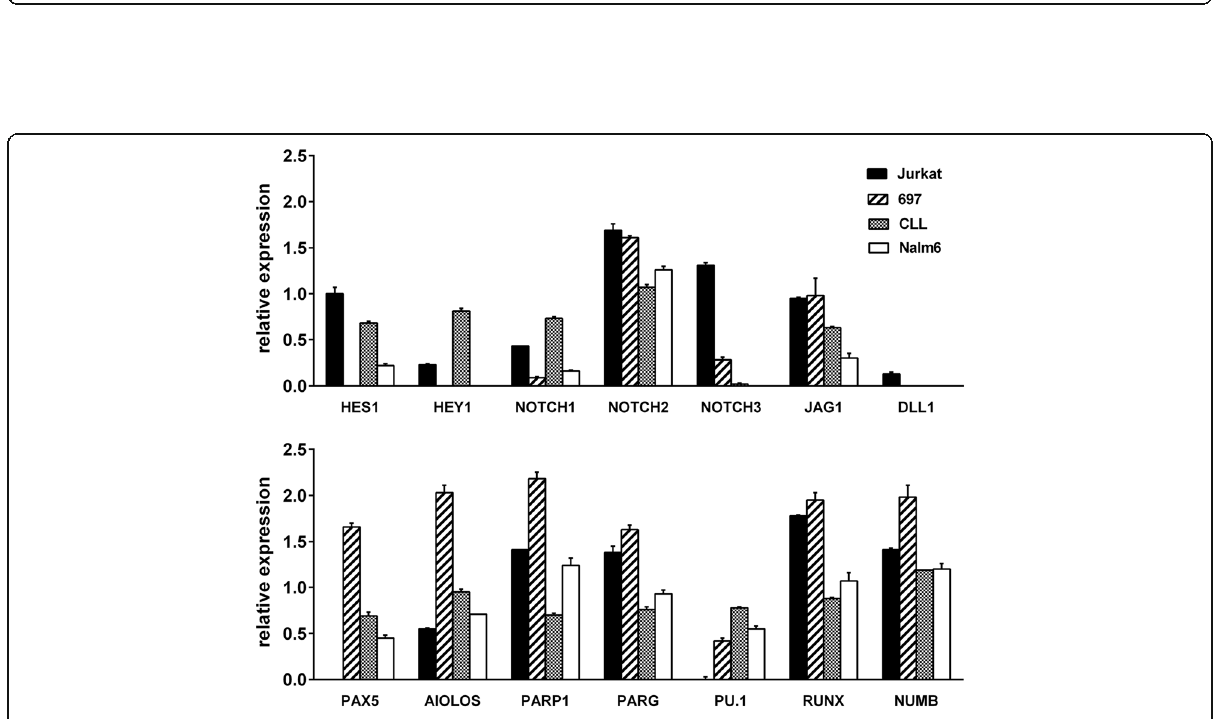
Fig. 2 Relative expression of Notch (upper panel) and PARP (lower panel) pathways by RT-PCR in cell lines of B and T cell origin (cDNA obtained from Jurkat, 697, Nalm-6 and CLL cell lines). Relative expression by band densitometry after gel electrophoresis of PCR amplicons, normalised with the level of HPRT expression. M ± SD of two independent